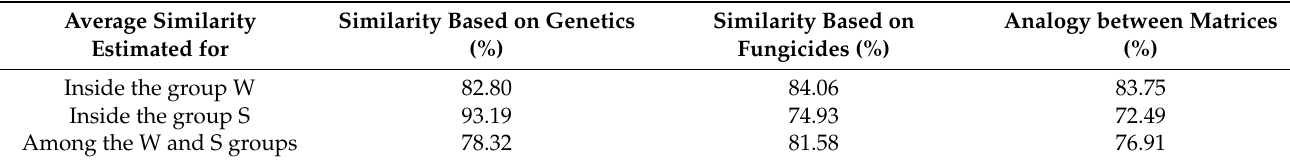
Table 8. Combined average similarity in group S and W and among both